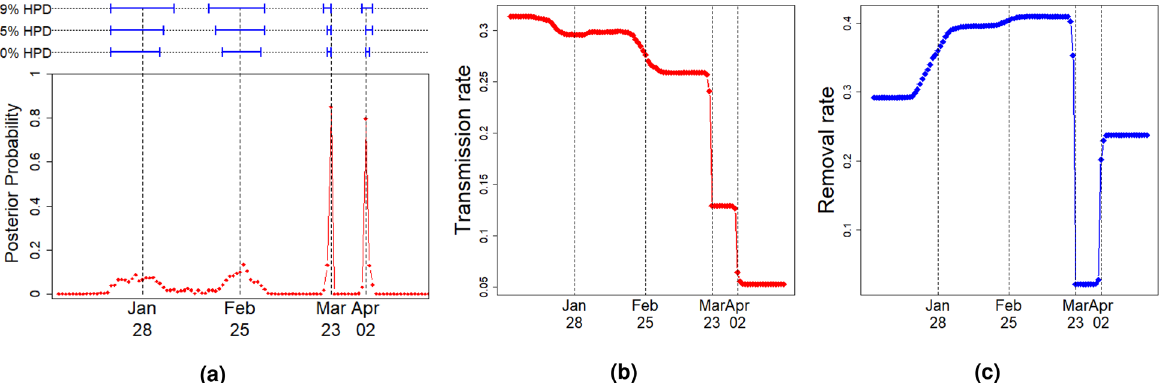
Figure 6. The Bayes estimator of ( a ) δδδ and 95% probability regions (HPD intervals) for change points; ( b ) the expected transmission rate; and ( c ) the expected removal